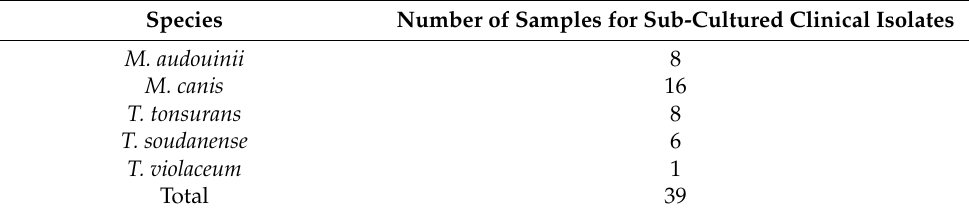
Table 2. Number of samples of the sub-cultured clinical dermatophyte isolates per species. Species Number of Samples for Sub-Cultured Clinical Isolates